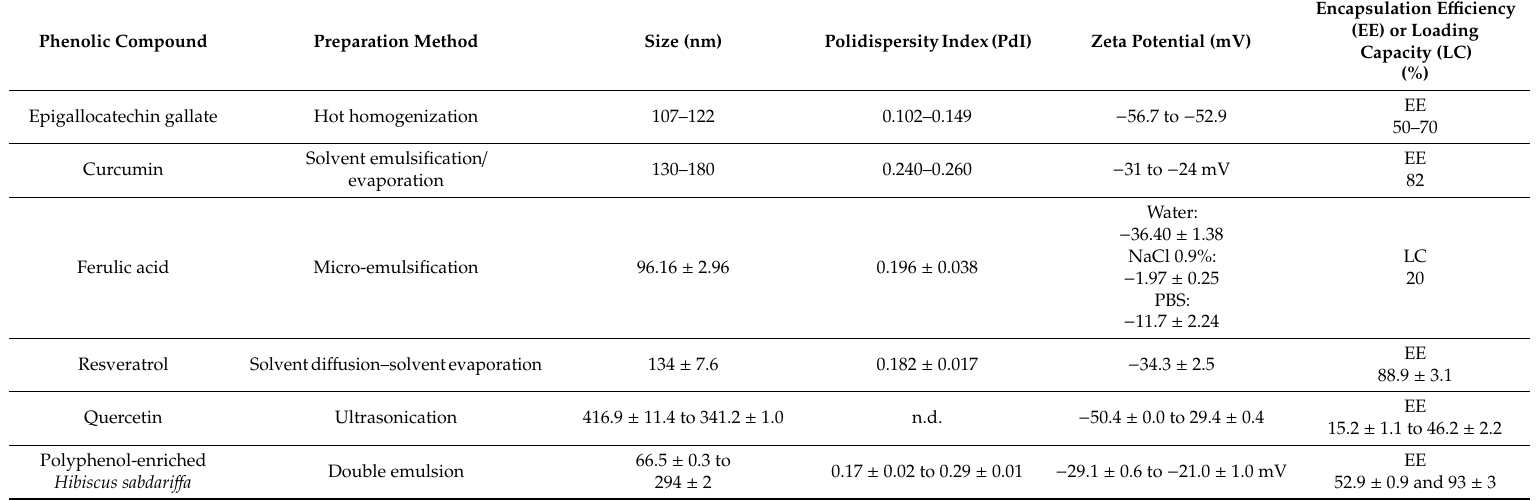
Table 3. Physical-chemical properties of phenolic compounds encapsulated in SLNs using di ff erent methods. n.d, non